Question: Write a single sentence explaining what this figure depicts.
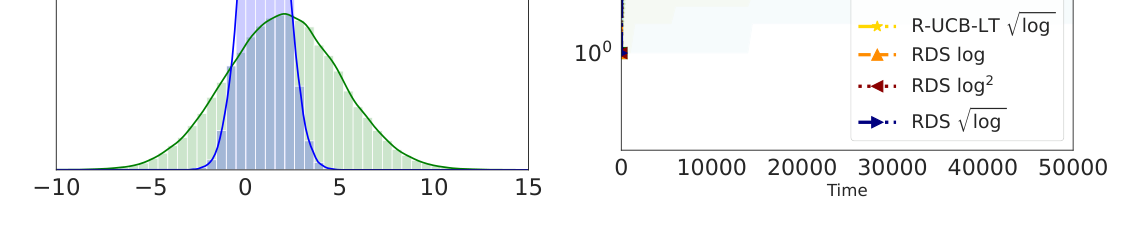
Answer: 2 – Linear fit (dashed) of log Kmax Yn+1 inf (bνYn+1; µ) (solid) on log log n and resulting slopes. Dotted lines correspond to log KF inf(ν; µ) for the corresponding SPEF F. X-axis: log log n. Y-axis: log Kinf.